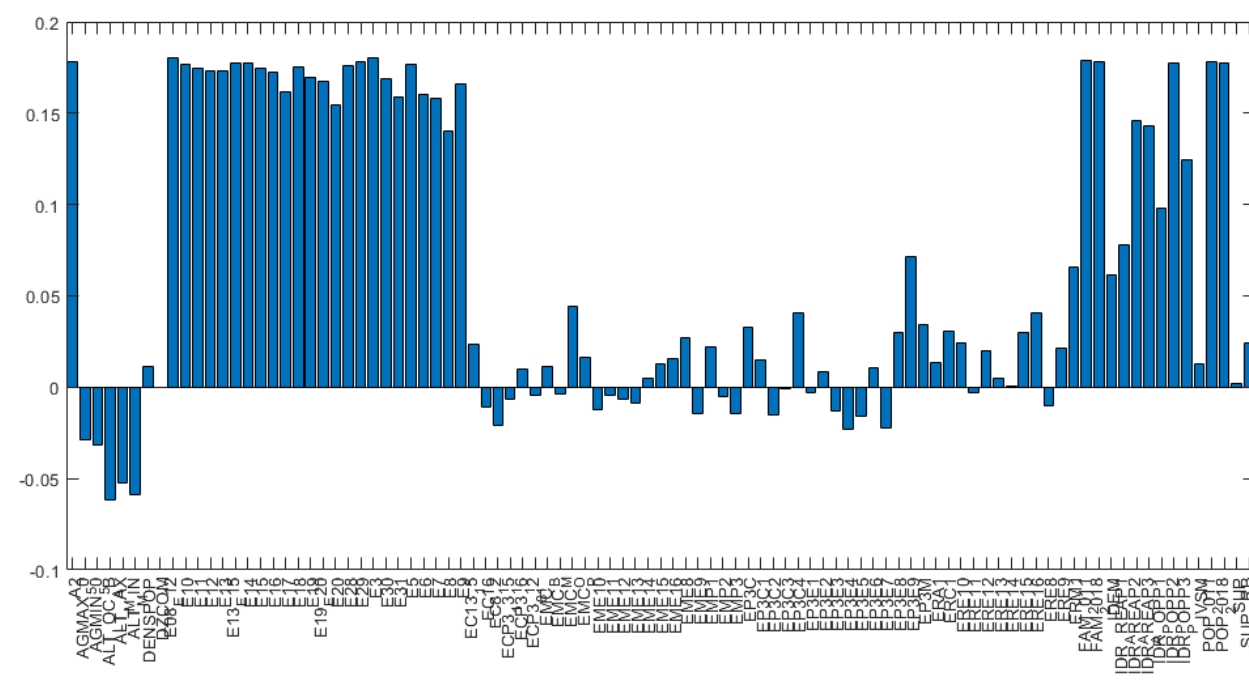
Figure 5. Loading plot of the variable coefficients along the first principal component (see Appendix A for an explanation of the acronyms).